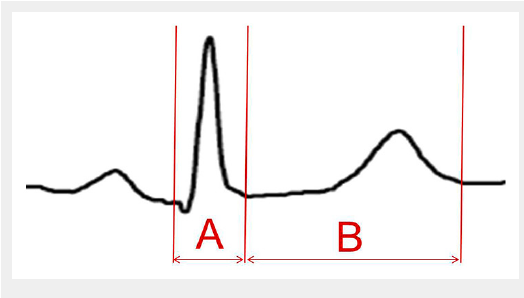
Normal sinus beat from lead II of a 12-lead ECG. Period (A) marks the ventricular depolarisation occurring during the QRS complex. Period (B) marks ventricular repolarisation consisting of the ST- segment and the